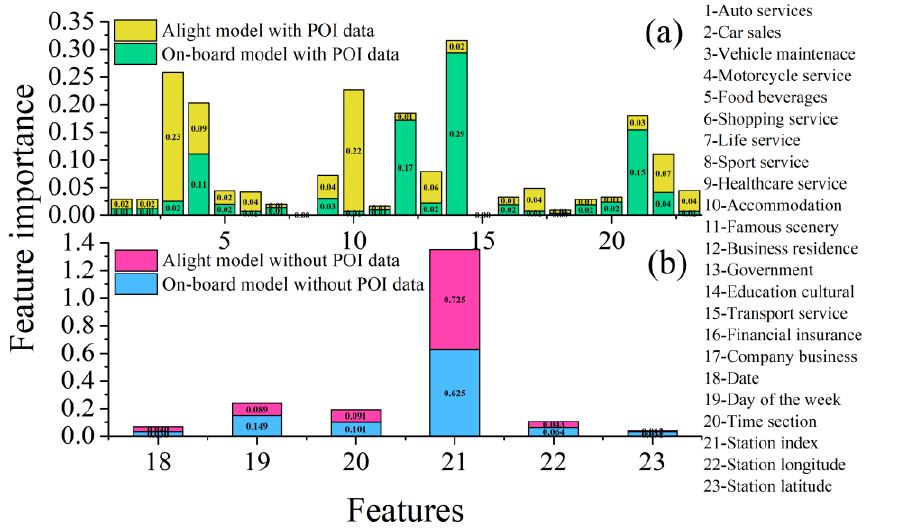
data ( b Figure 7. The feature importance of different XGBoost models with POI data ( a ) and without POI data ( b ).